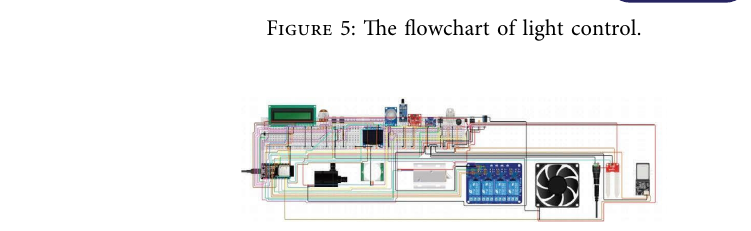
Figure 6: Te circuit